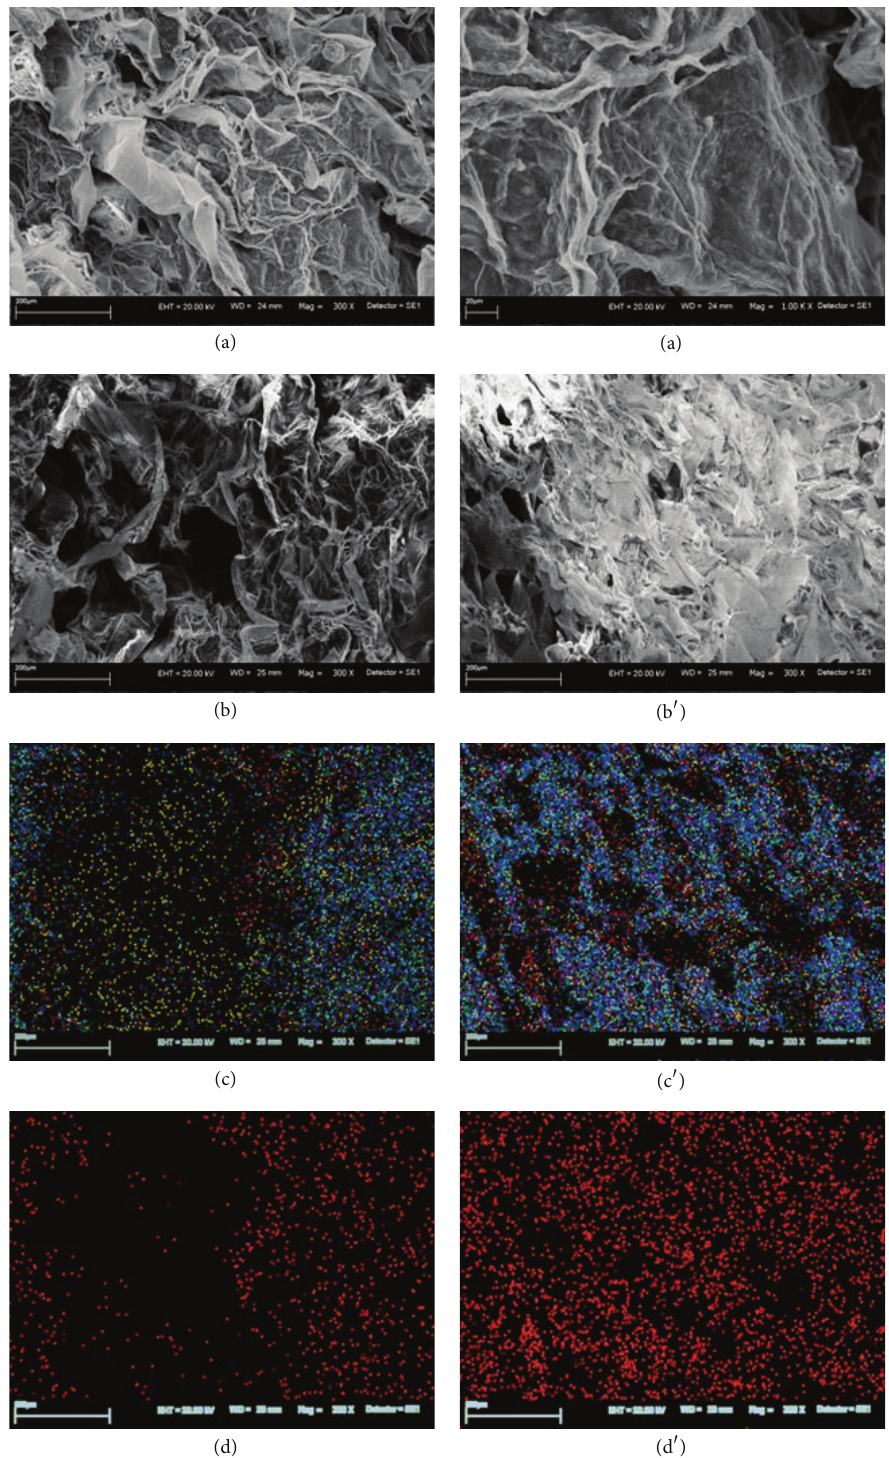
Figure 2: (a) A picture of the surface of Vaucheria sessilis enriched with Zn(II) ions; bottom picture of the surface (b) and cross section (b 󸀠 ) of macroalga; mapping of all elements on the surface (c) and in the cross section (c 󸀠 ); mapping of Zn(II) ions on the surface (d) and in the cross section (d 󸀠 ) (C—green, O—dark blue, Na—bright blue, Al—yellow, Zn—red, and